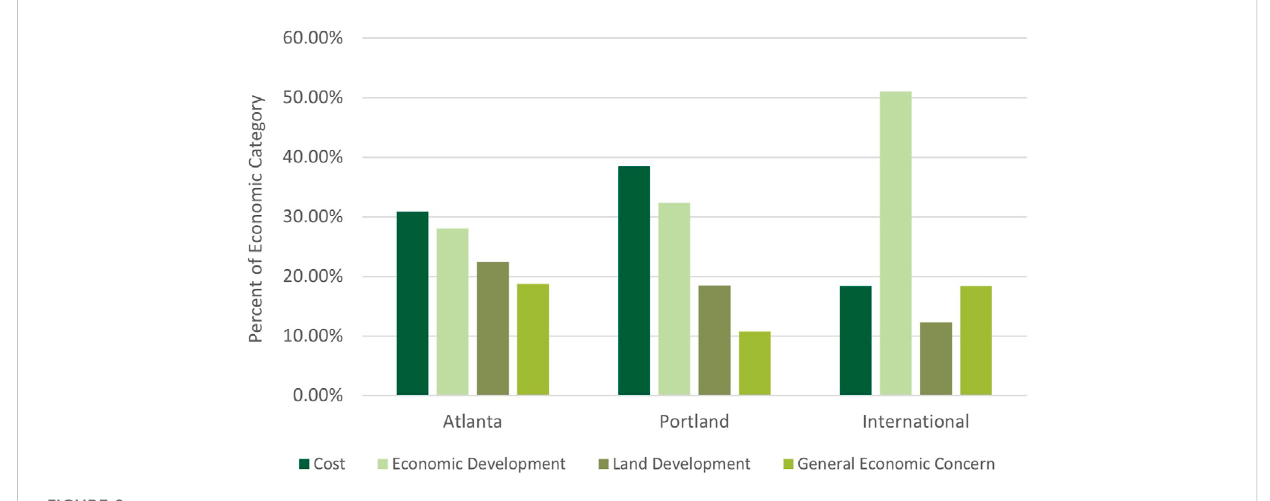
FIGURE 2 Subcategory fi ndings and comparison of economic codes between both cities and International